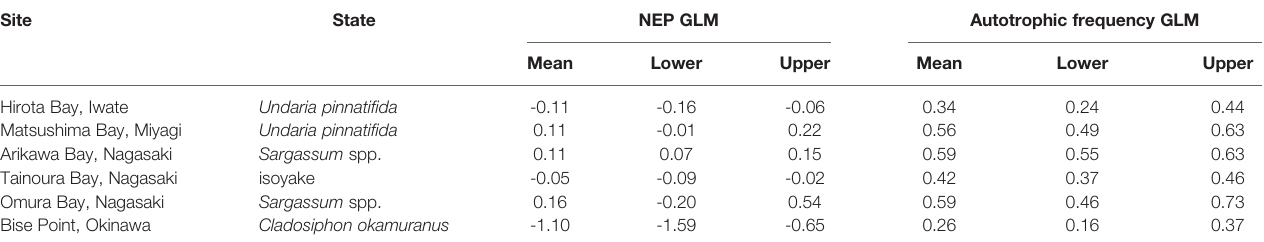
TABLE 3 | The mean and 95% highest density credible interval for the expectations of the generalized linear model (GLM) of the net ecosystem production (NEP) and the autotrophic frequency.